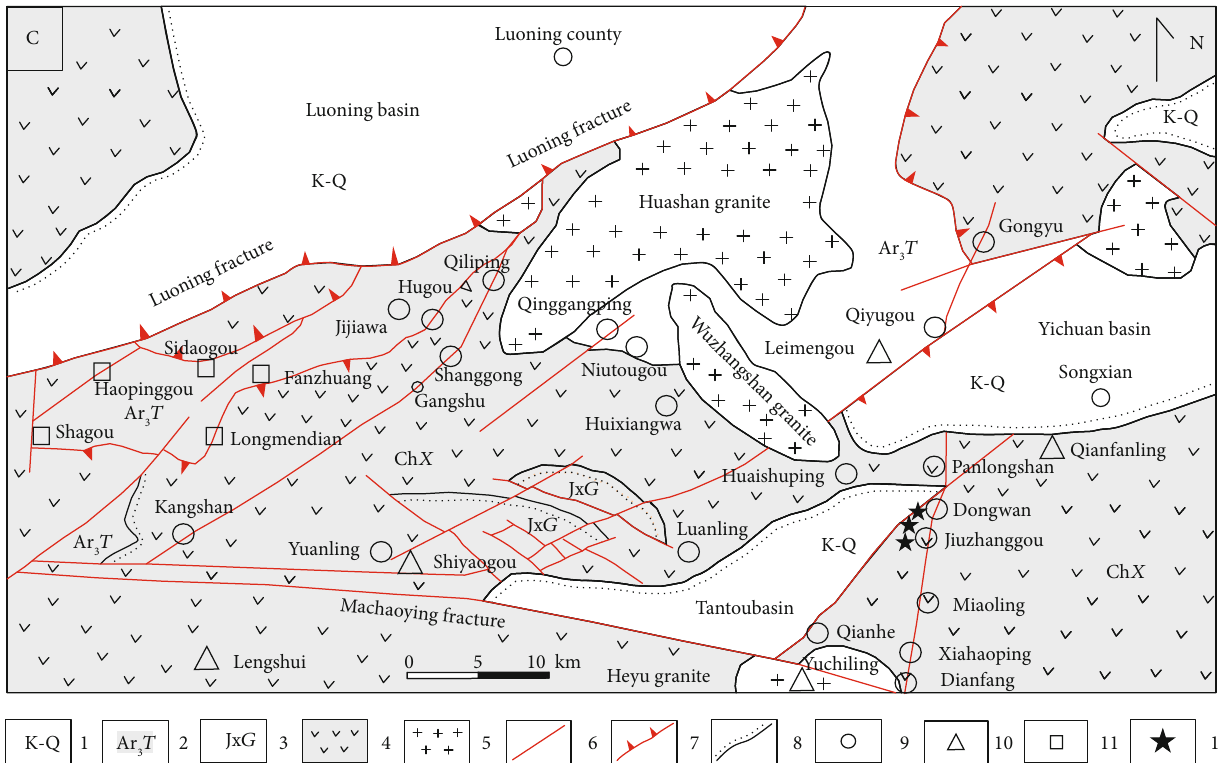
Figure 2: Regional geological map of the Xiong ’ er Mountain Area. (after Pang et al. [14]). 1: quaternary sediments; 2: Taihua Group; 3: Guandaokou Group; 4: Xiong ’ er Group; 5: magmatic of Yanshanian; 6: faults; 7: detachment faults; 8: unconformity geological boundary; 9: gold deposit; 10: Mo deposit; 11: Ag-Pb-Zn deposit; 12: zircon sampling